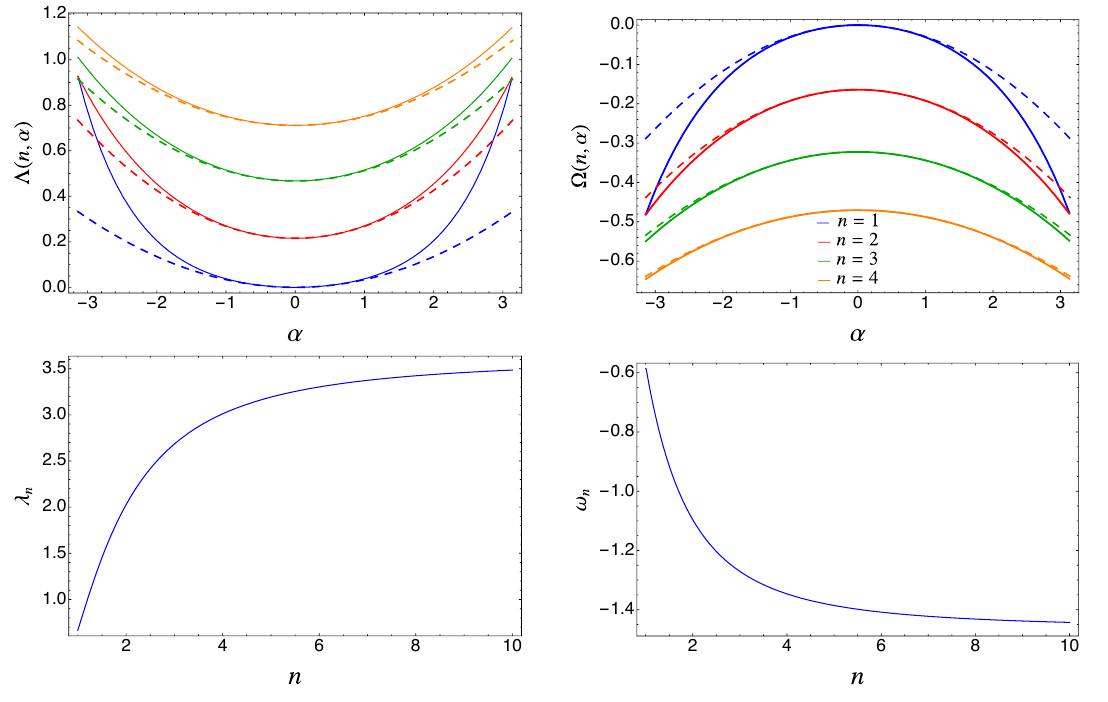
Figure 11 . Top panels: (cid:3)( n; (cid:11) ) (left) and (cid:10)( n; (cid:11) ) (right) in eq. (4.10) as a function of (cid:11) for n = 1 ; 2 ; 3 ; 4. The exact forms (full lines) are compared with the quadratic approximation (dashed lines) showing that, although very close, they are de(cid:12)nitively di(cid:11)erent. Bottom panels: ! n and (cid:21) n reported in eq. (4.10) are plotted as a function of n . Their non trivial dependence on n gives rise to the subleading terms breaking the equipartition of entanglement in a massive Dirac (cid:12)eld theory, as illustrated in section